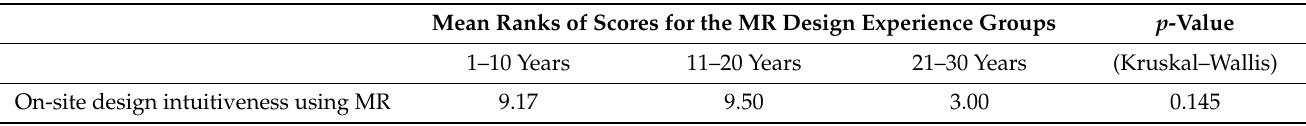
On-site design intuitiveness using